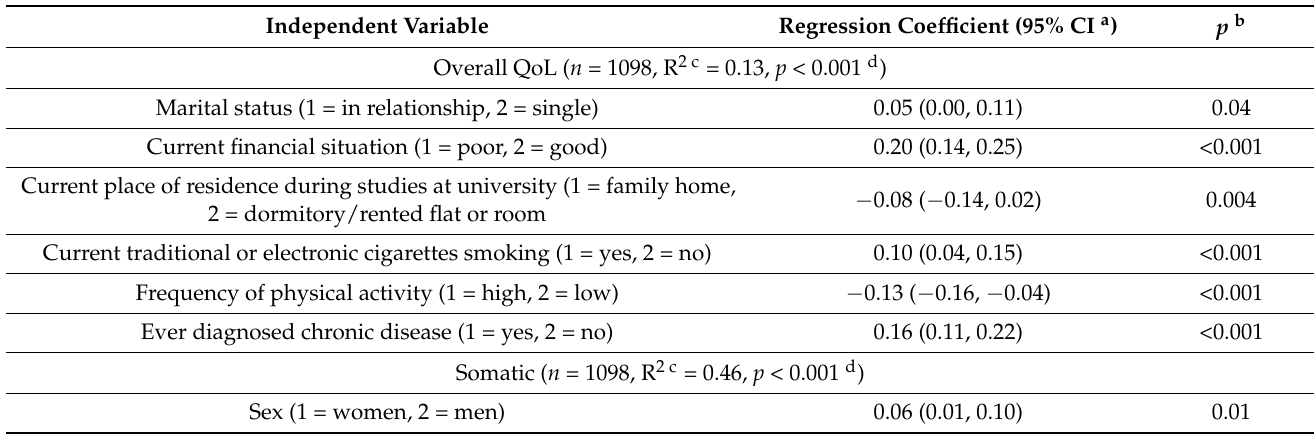
Table 4. Results of multivariable linear regression models for the relationship between QoL domains and particular independent variables ( n =